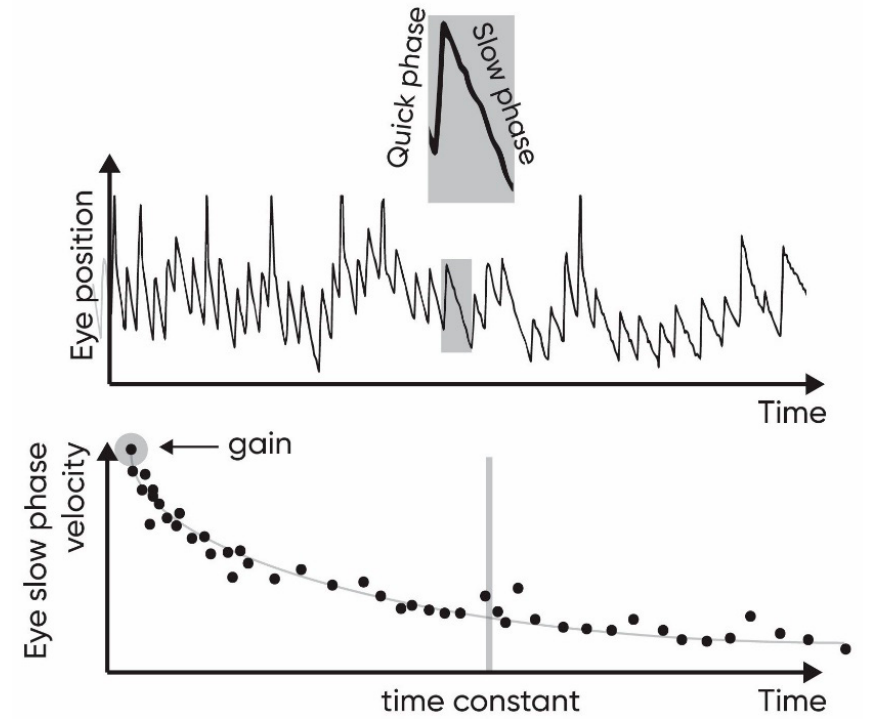
Figure 1. The ocular movement track of position ( upper panel) and slow phase velocity ( lower panel). The two parameters evaluated are the gain and the time constant of the slow phase velocity of ocular compensation.